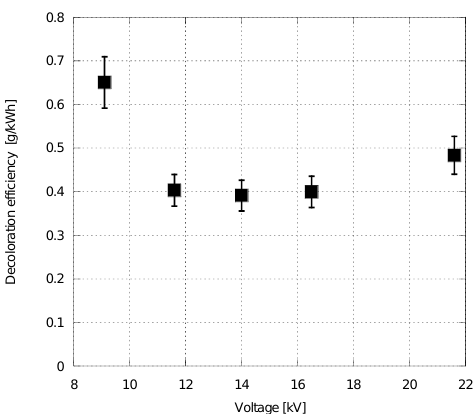
Figure 11. Energy efficiency of 40% decoloration of indigo carmine dye at different applied voltage amplitudes of water surface streamer discharge.